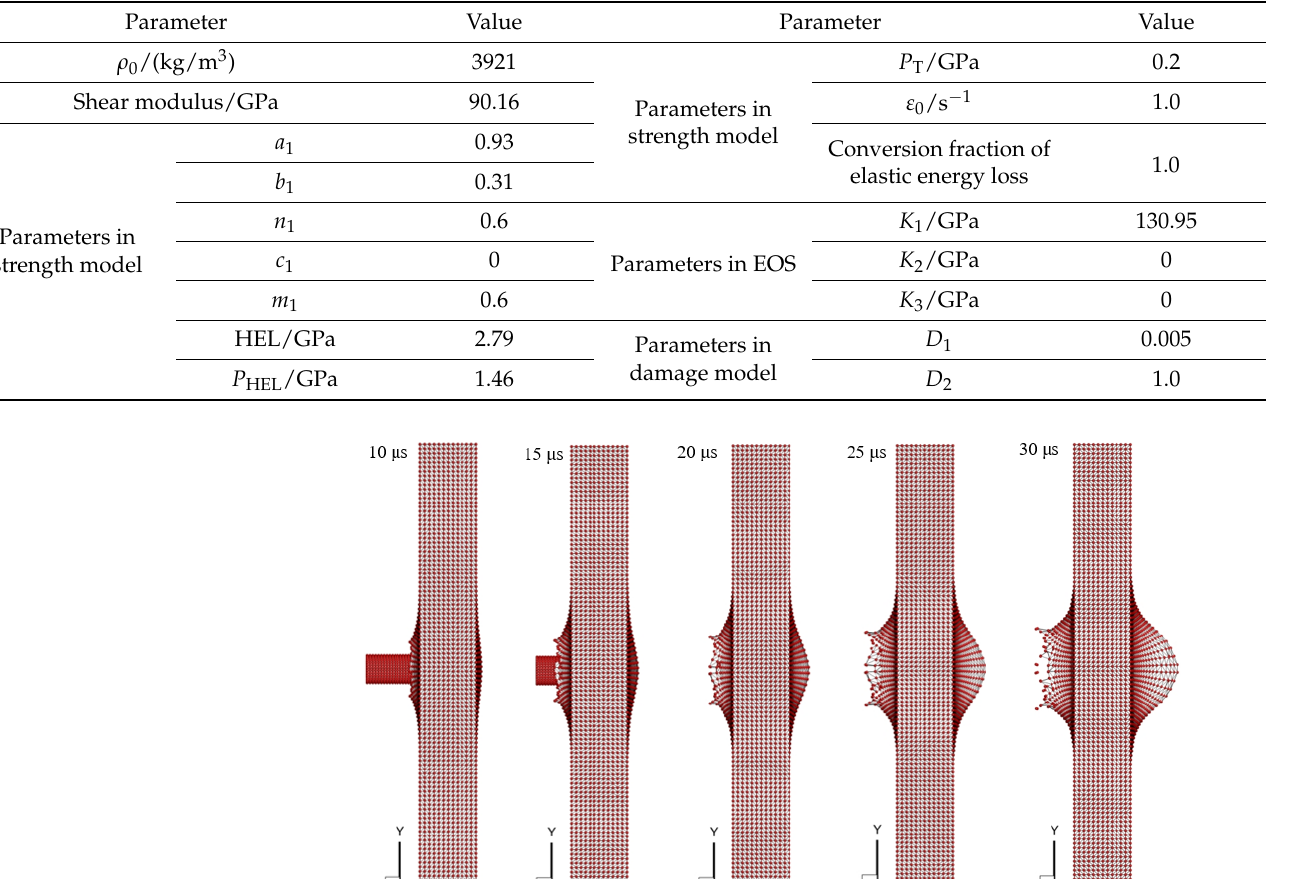
Table 2. Material parameters for ceramic material.